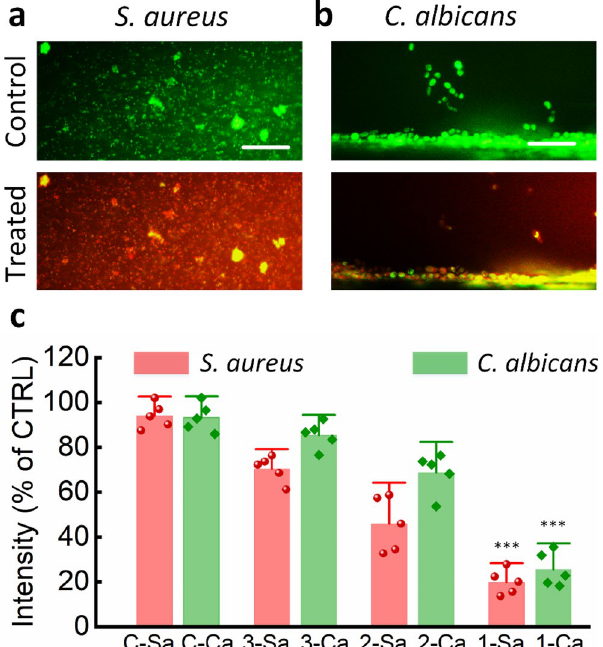
Figure 6. Laser treatment of the mono-species biofilm of S. aureus and C. albicans for 90 min at various irradiances: ( a ) untreated control (top) and treated samples (bottom) of the S. aureus biofilm, ( b ) untreated control (top) and treated samples (bottom) of C. albicans biofilm grown on channel 1, and ( c ) comparison of measured fluorescence intensities (fluences on channels 1, 2, and 3 = 1080, 540, and 270 J/cm 2 , respectively; scale bar = 20 μm; C-Sa untreated control samples of S. aureus biofilm, 1-Sa, 2-Sa, 3-Sa treated samples of S. aureus on channels 1, 2, and 3, respectively, C-Ca untreated control samples of C. albicans biofilm, 1-Ca, 2-Ca, 3-Ca treated samples of C. albicans on channels 1, 2, and 3, respectively; *** p < 0.01 vs. untreated control; N = 5).